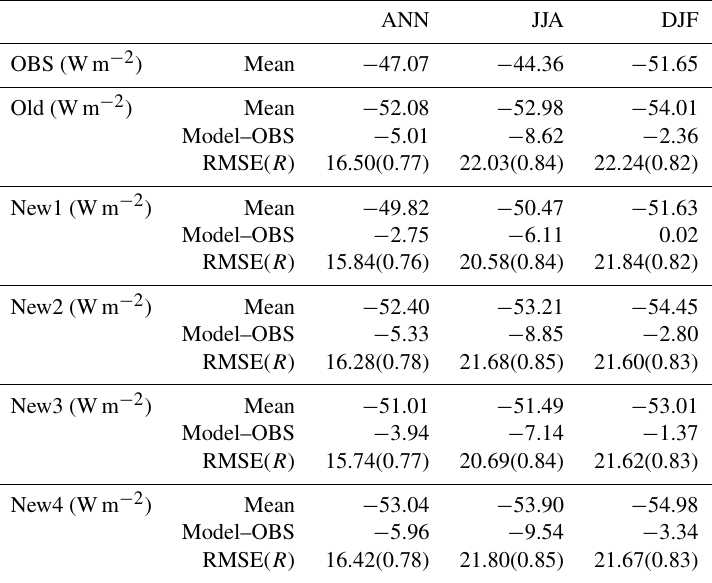
Table 3. Mean (annual and seasonal global mean values) and Model–OBS (the difference of annual and seasonal global mean values between models and observations), RMSE (root mean squared error), and R (spatial pattern correlation) of the modeling results compared to the observed SWCF from CERES-EBAF for ANN, JJA, and DJF.